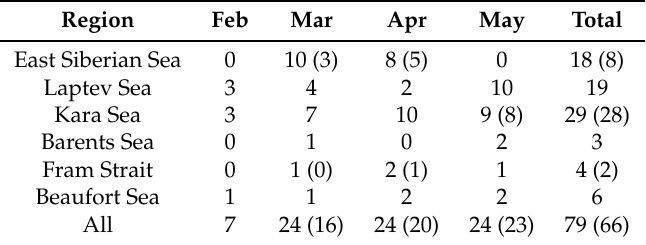
Table 1. Number of Sentinel-2 scenes for the respective region and month. If there is a number in brackets, it gives the number of scenes after discarding Sentinel-2 scenes for which no cloud-free MODIS measurement is available within two hours of the acquisition. In those without brackets all scenes could be